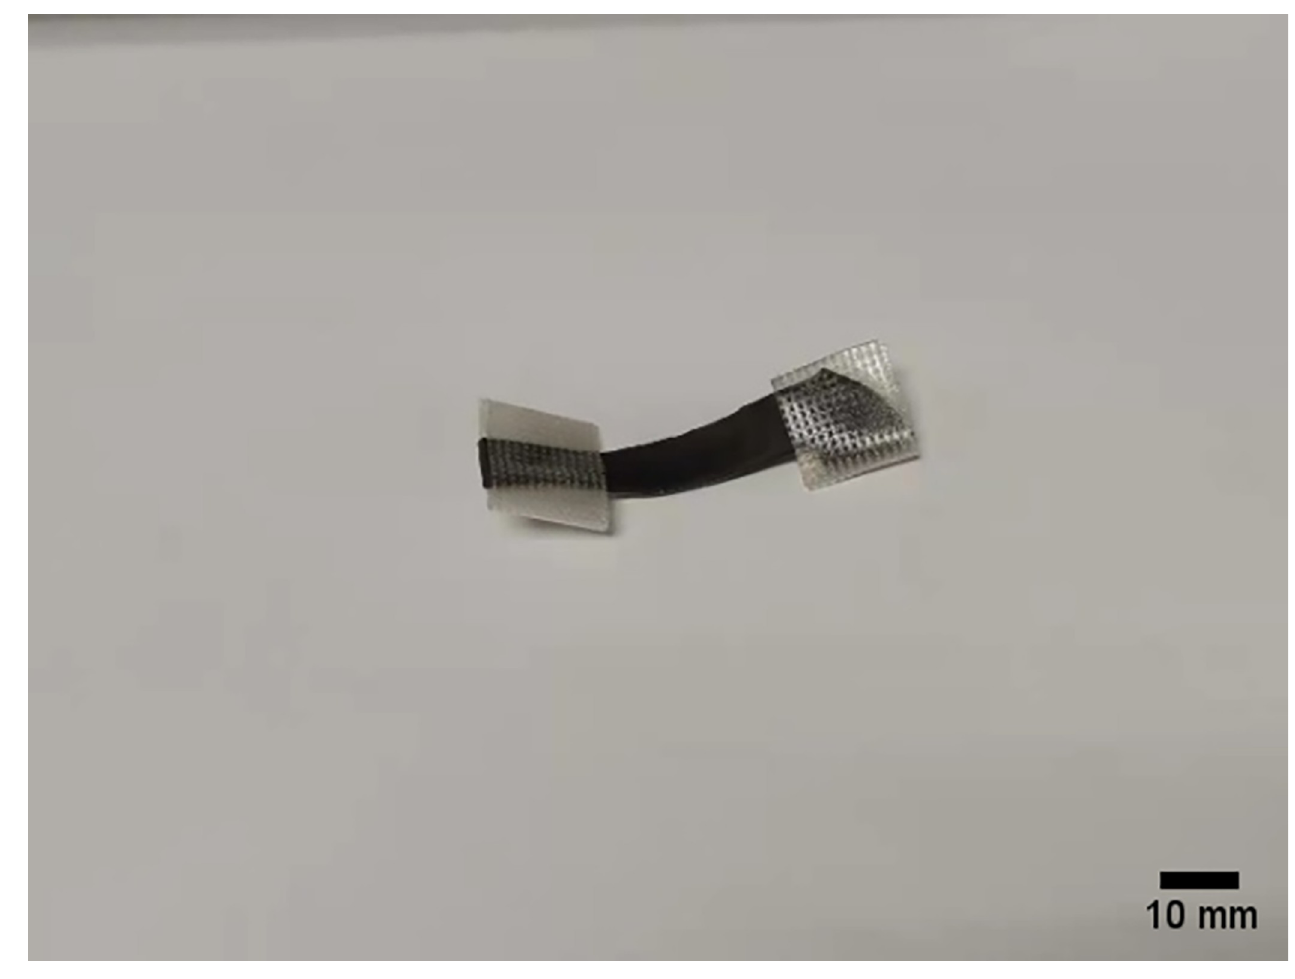
Fig 5. Specimen of a black fungus